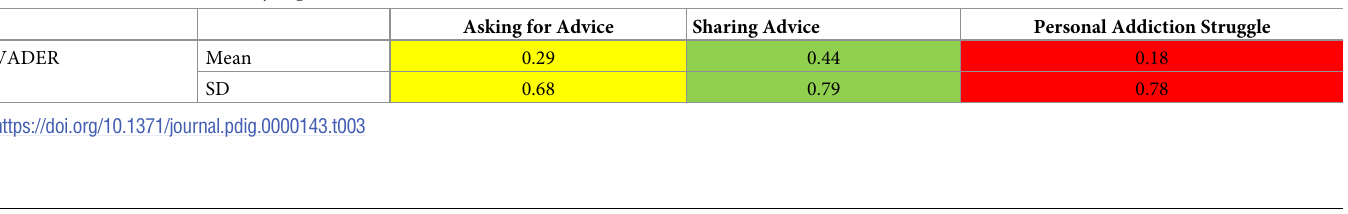
Table 3. VADER sentiment analysis per